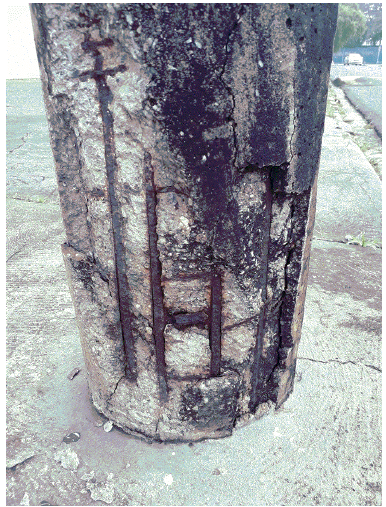
Figure 1 – Reinforcements’ corrosion in a reinforced concrete